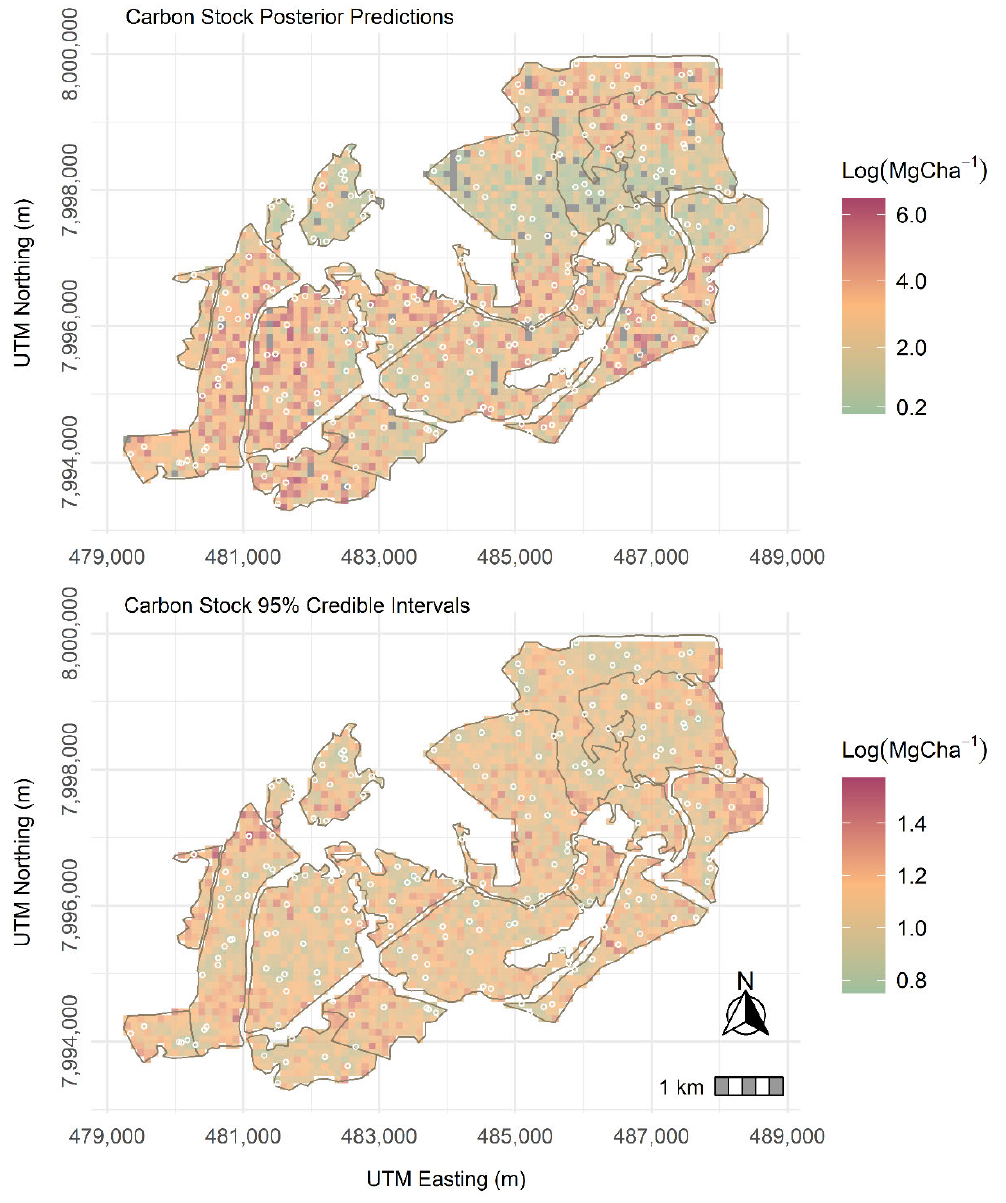
Figure 6. Sentinel ‐ 2 ‐ based C stock posterior predictions. Figure 6. Sentinel-2-based C stock posterior